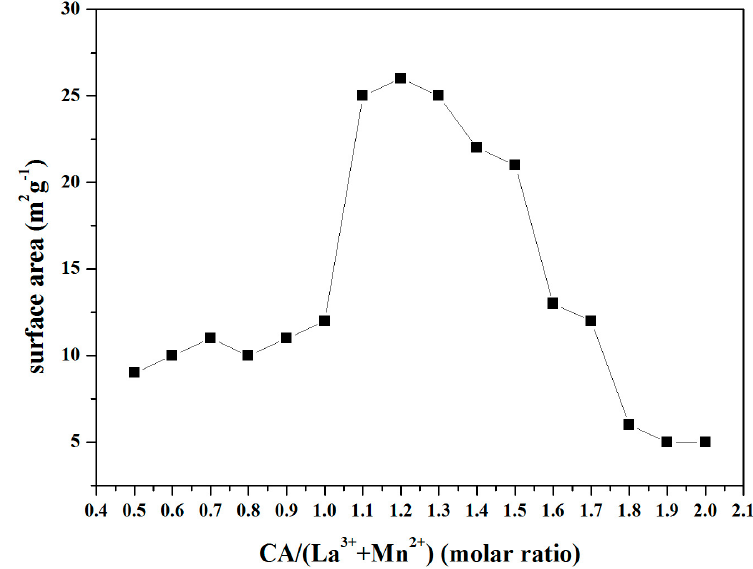
Figure 2. Relationship between the specific surface area of the catalysts and the molar ratio of CA to total metal ions (La 3+ + Mn 2+ ).